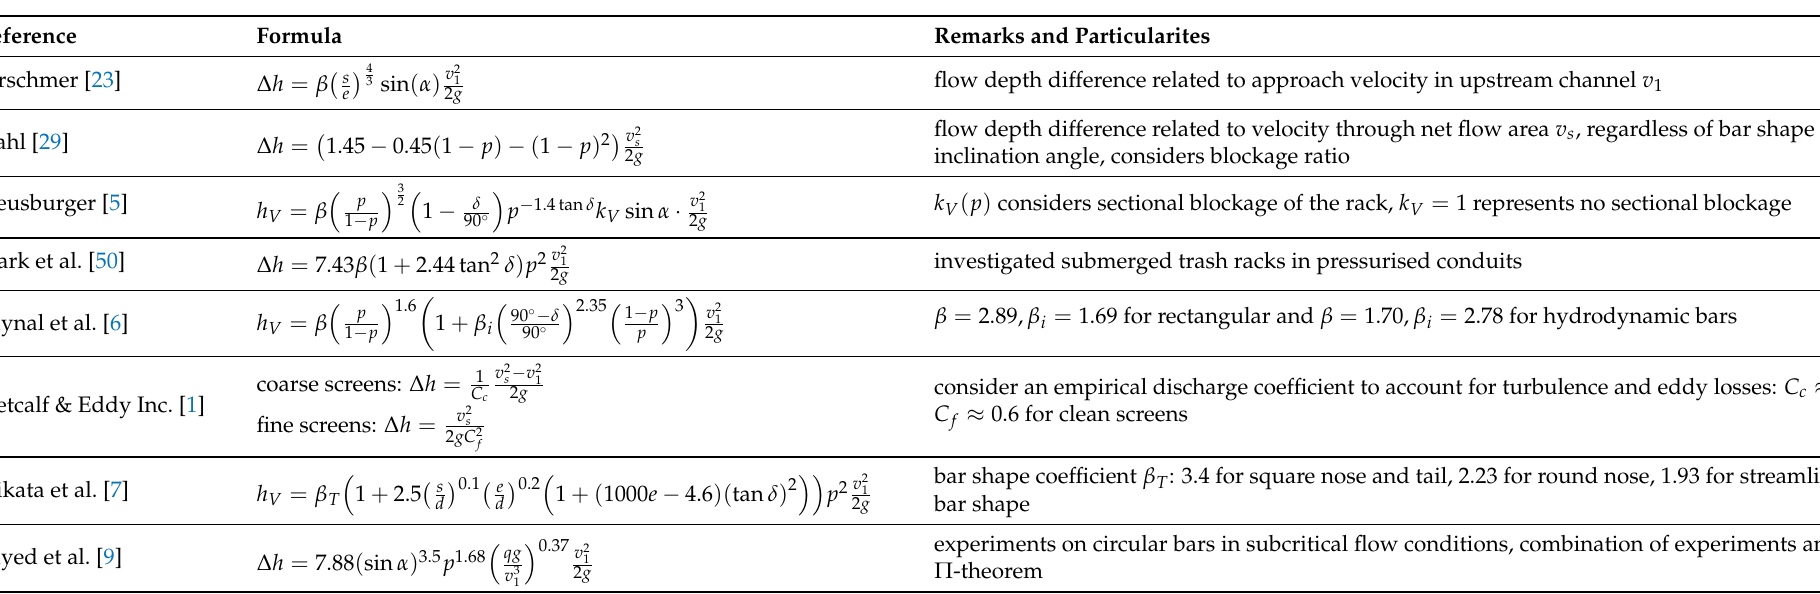
Table 1. Selection of empirical formulas which are most relevant in this study to determine the flow depth difference ∆ h or the hydraulic head loss h V along